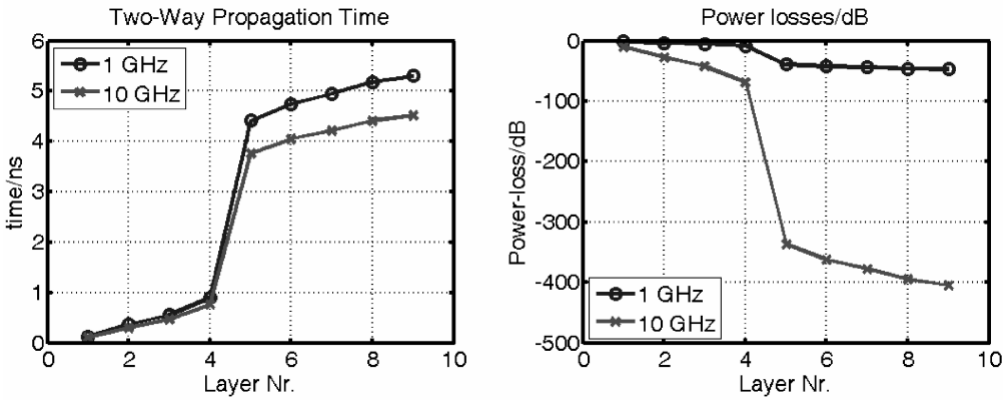
Figure 7. Two-way propagation time and one-way power losses of the layered human head model: Left: calculated propagation time after each layer for two different frequencies. Propagation times to reach a certain interface are indicated by the data points. The lines are guides to the eye. Right: power losses after each layer of the electromagnetic wave while traversing the 9-layer model computed for two different frequencies.